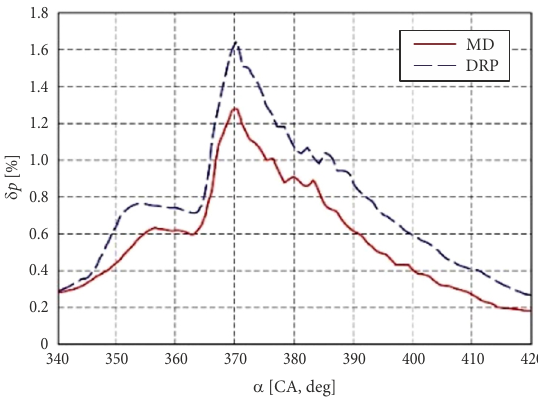
Figure 5. Mean cycle-by-cycle differences in cylinder pressure vs CA for MD and DRP (3000 rpm / 150 N ⋅ m)